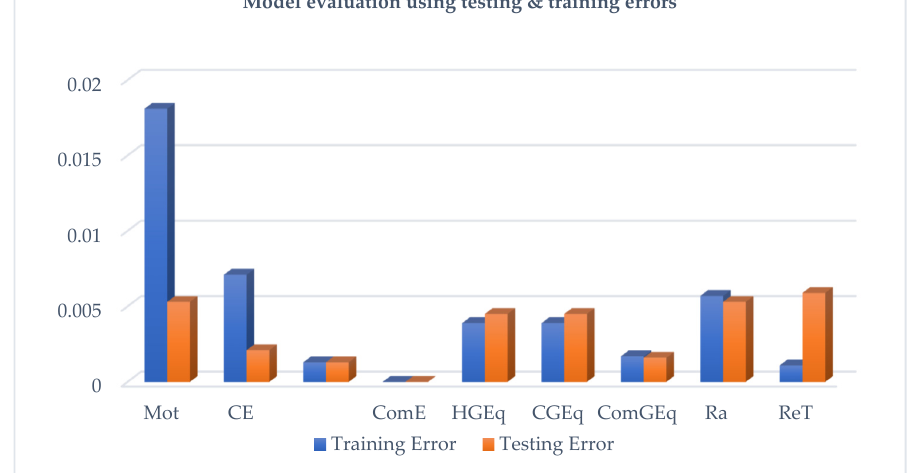
Figure 18. Model evaluation.